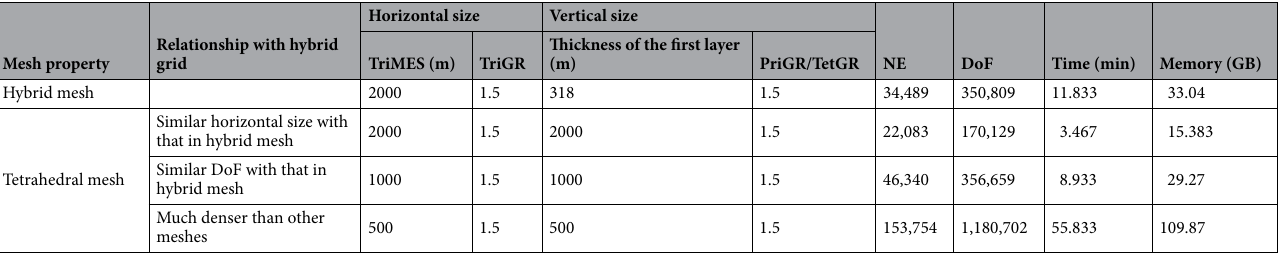
Table 3. Parameters of different meshes for DTM1